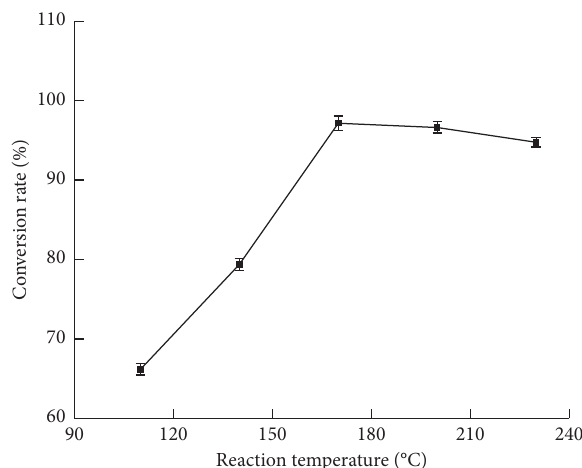
Figure 10: Effects of reaction time on the conversion rate of unsaturated